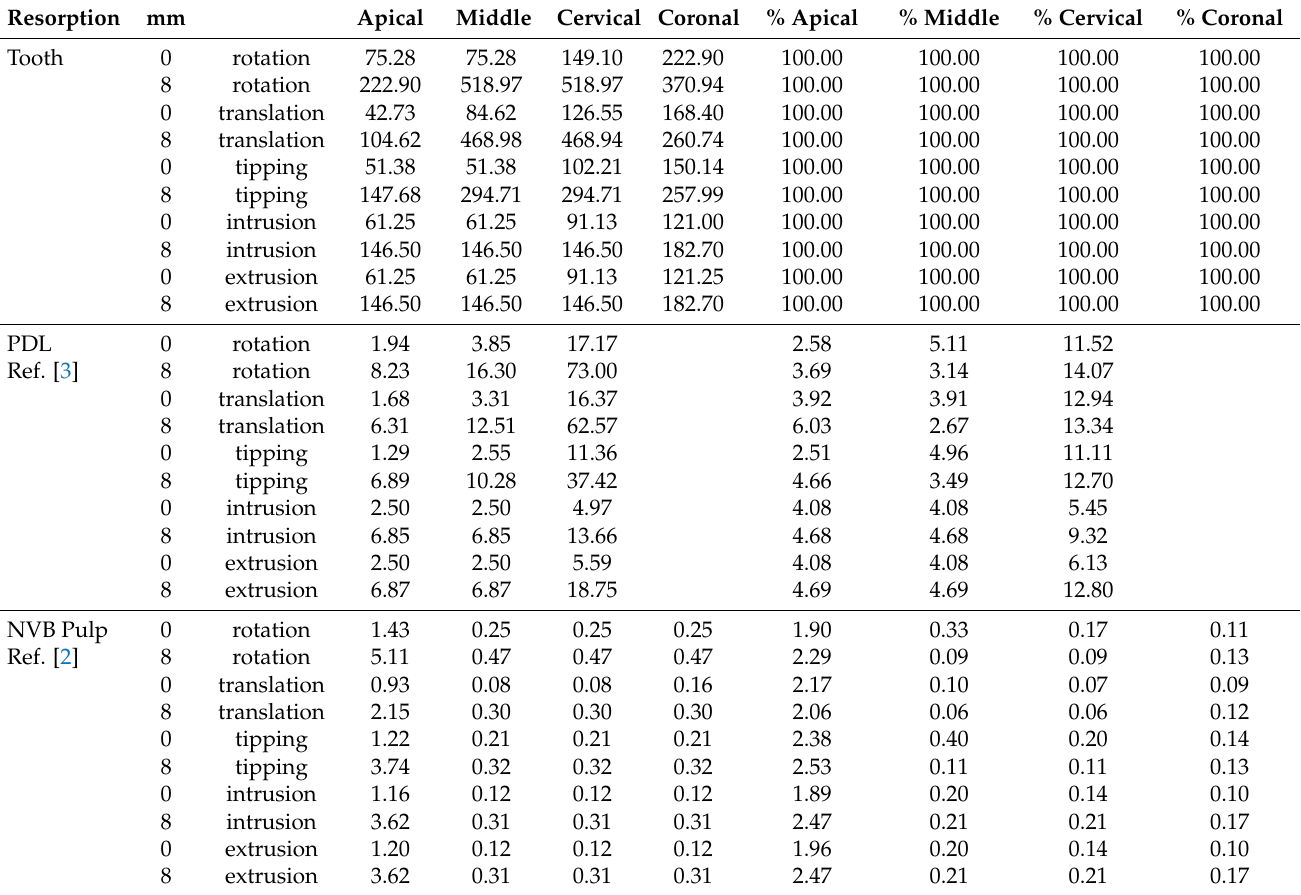
Table 3. Tresca criteria—maximum stress average values (KPa) produced by 0.5 N/50 g of force in tooth, PDL, NVB pulp, and % of the tooth quantitative stress that is displayed by the PDL, dental pulp, and NVB